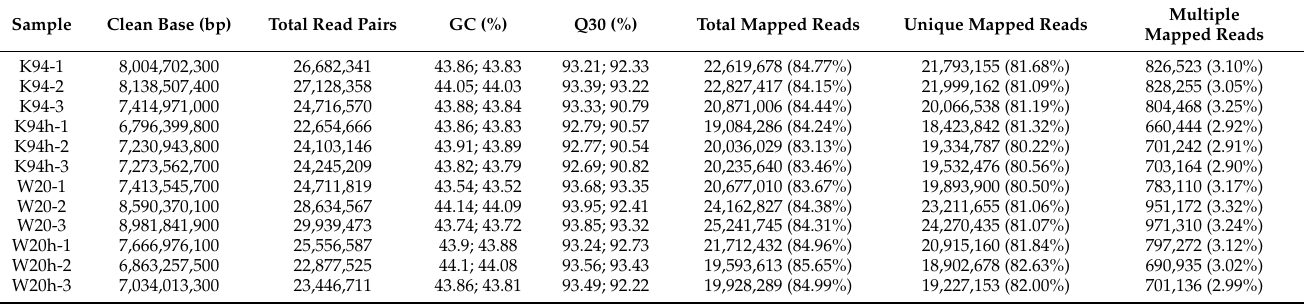
Table 2. Summary of RNA sequencing responses to salt stress in cannabis